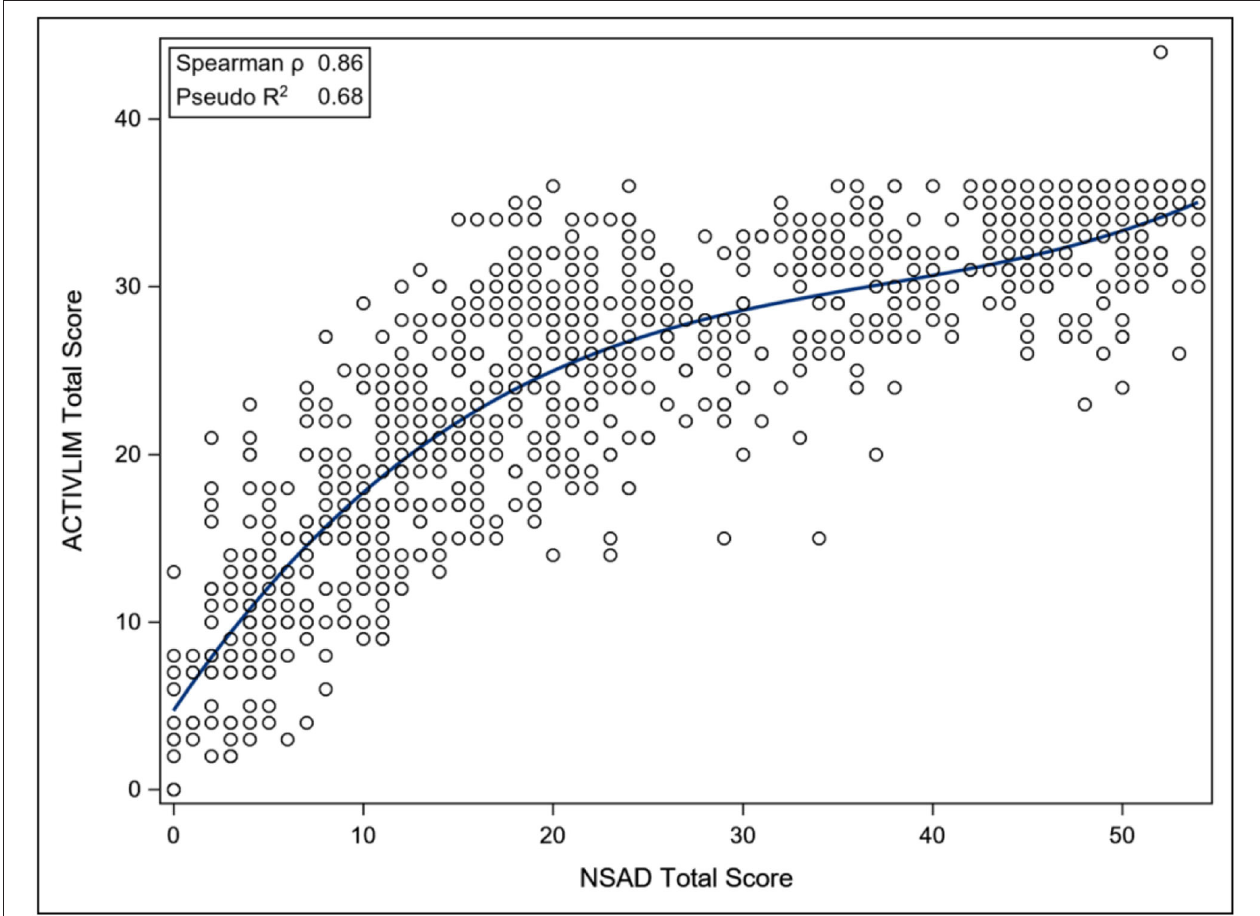
FIGURE 3 | Association between Total NSAD score and ACTIVLIM. NSAD, North Star Assessment for Limb Girdle Type Muscular Dystrophies; ACTIVLIM, Measure of Activity Limitations in Daily Living.